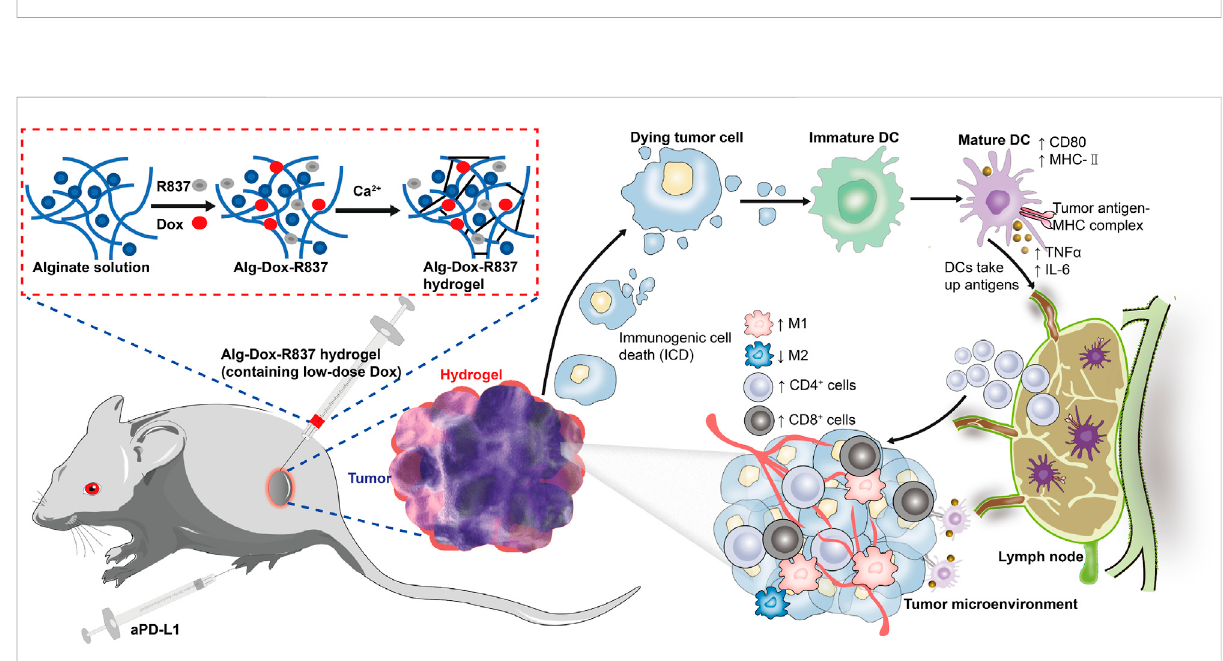
FIGURE 7 Schematic illustration of the mechanism of tumor immunotherapy by an engineered hydrogel through tumor interstitial wrap.